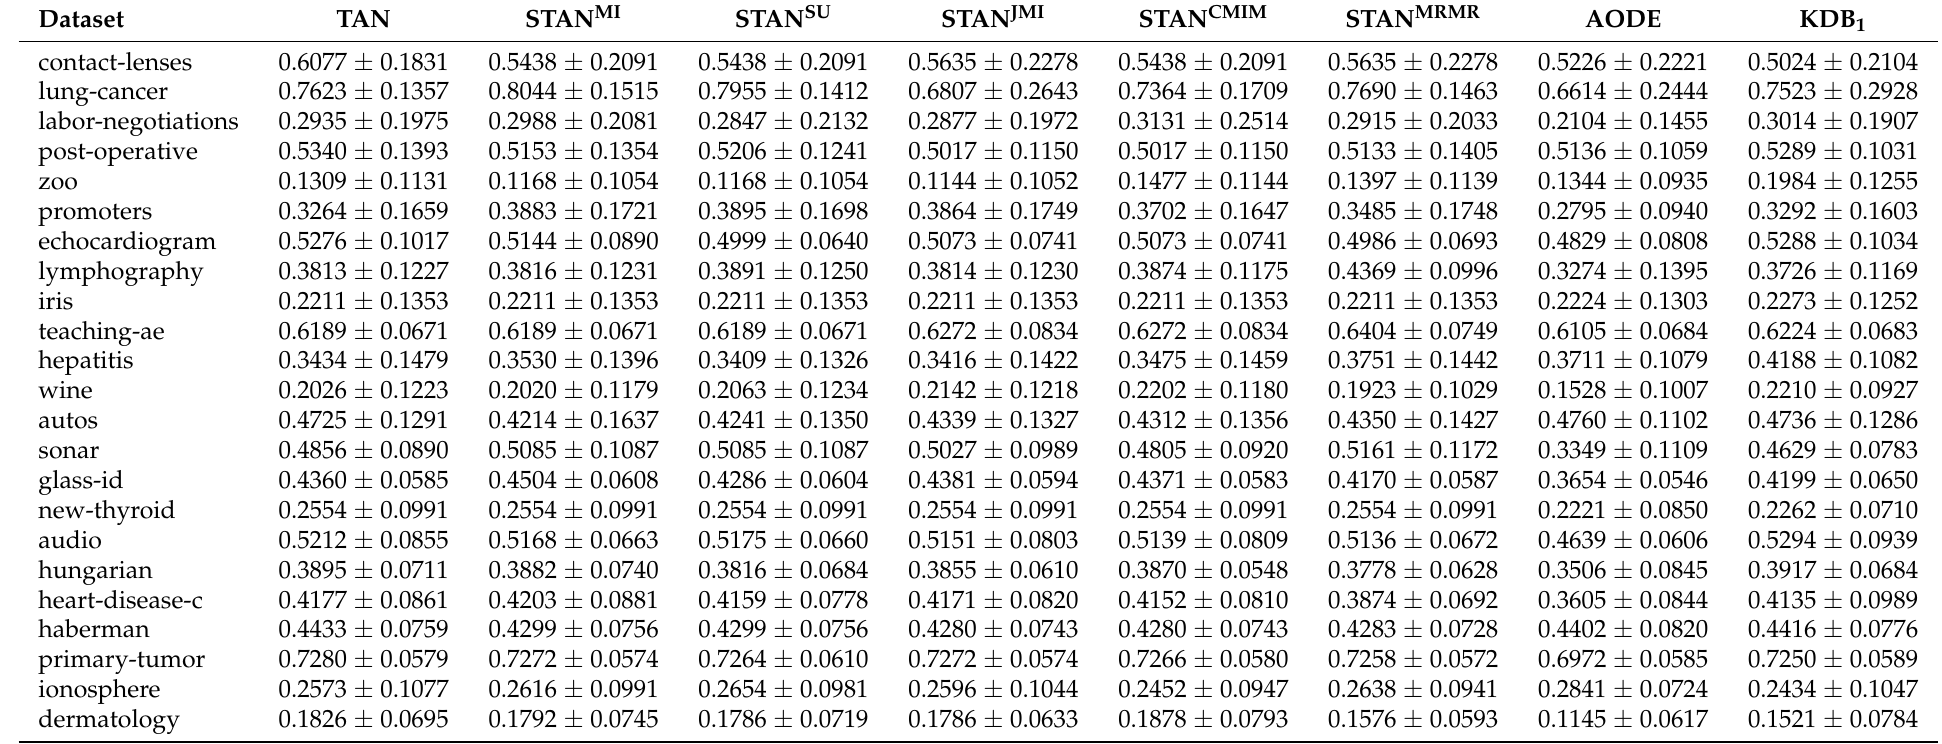
Table A2. RMSE results of 8 algorithms on 70 data